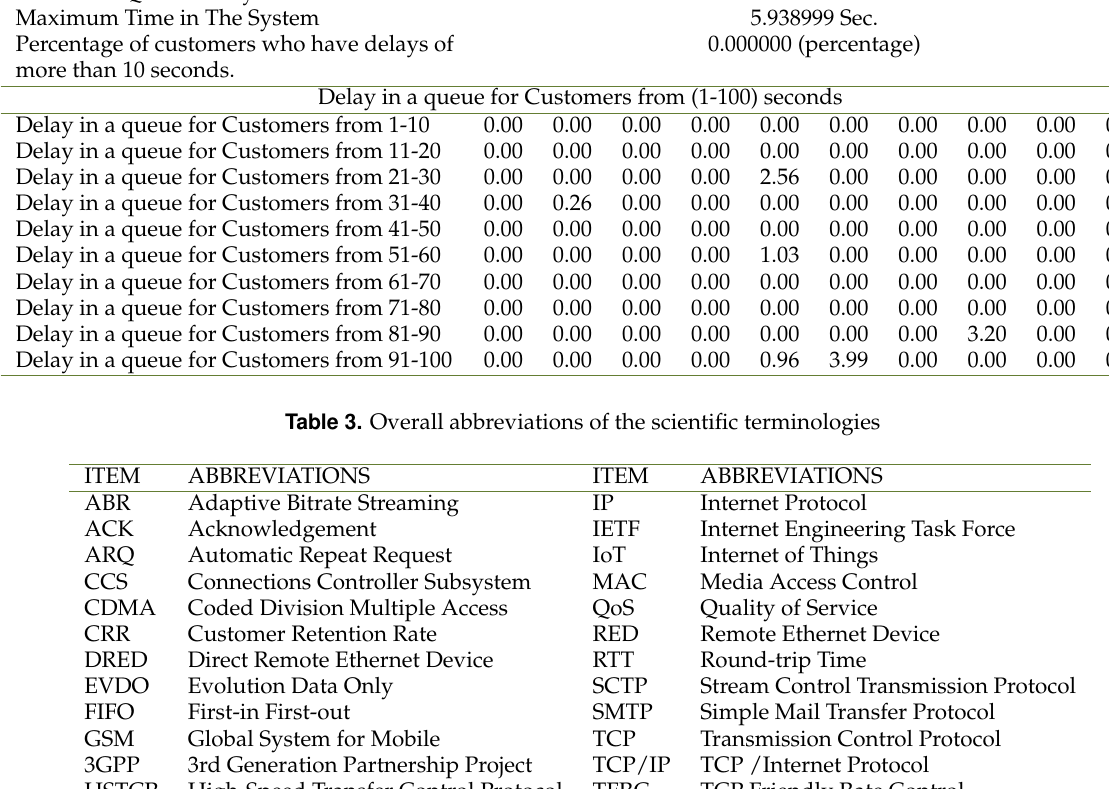
Table 2. The estimated delays for 10 regularly spaced groups of 100 customers entered into the system Probability of Blocking 0.000000 Average Number in The System